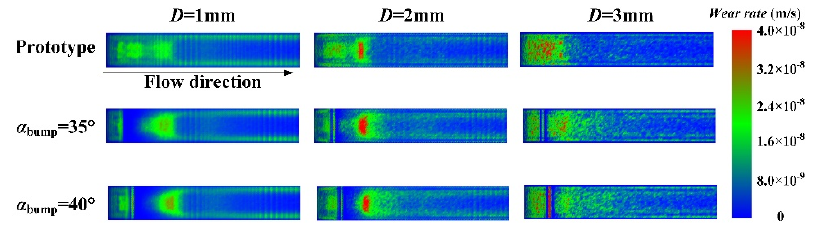
Figure 15. Contours of outer wall surface wear for different particle sizes.